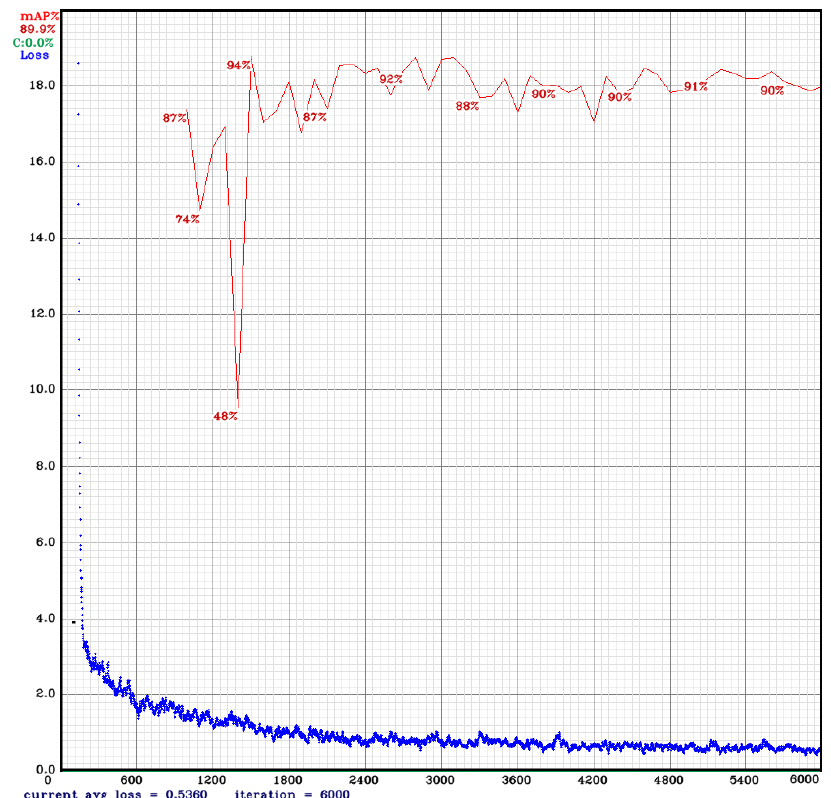
Figure 11. The progress of the loss value while training the method proposed by Tan et al. [43].